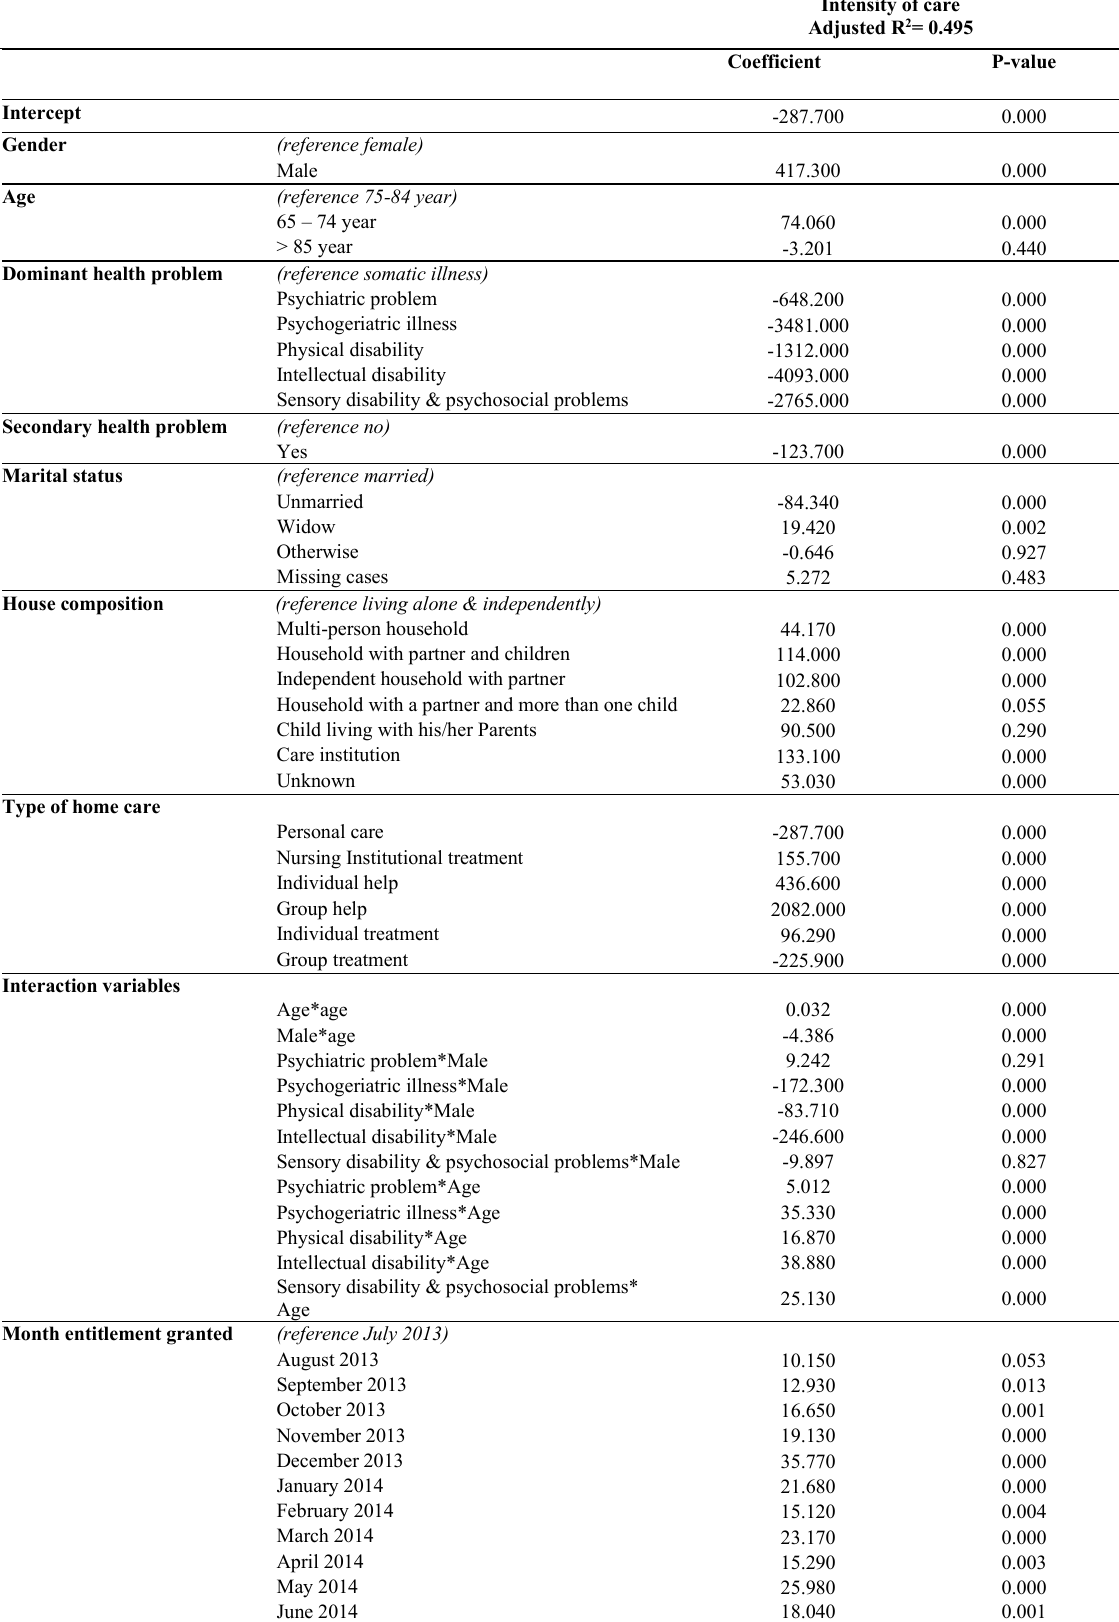
Table A2: Model 2 linear model for home care intensity 65 and older (excerpt: excluding care office